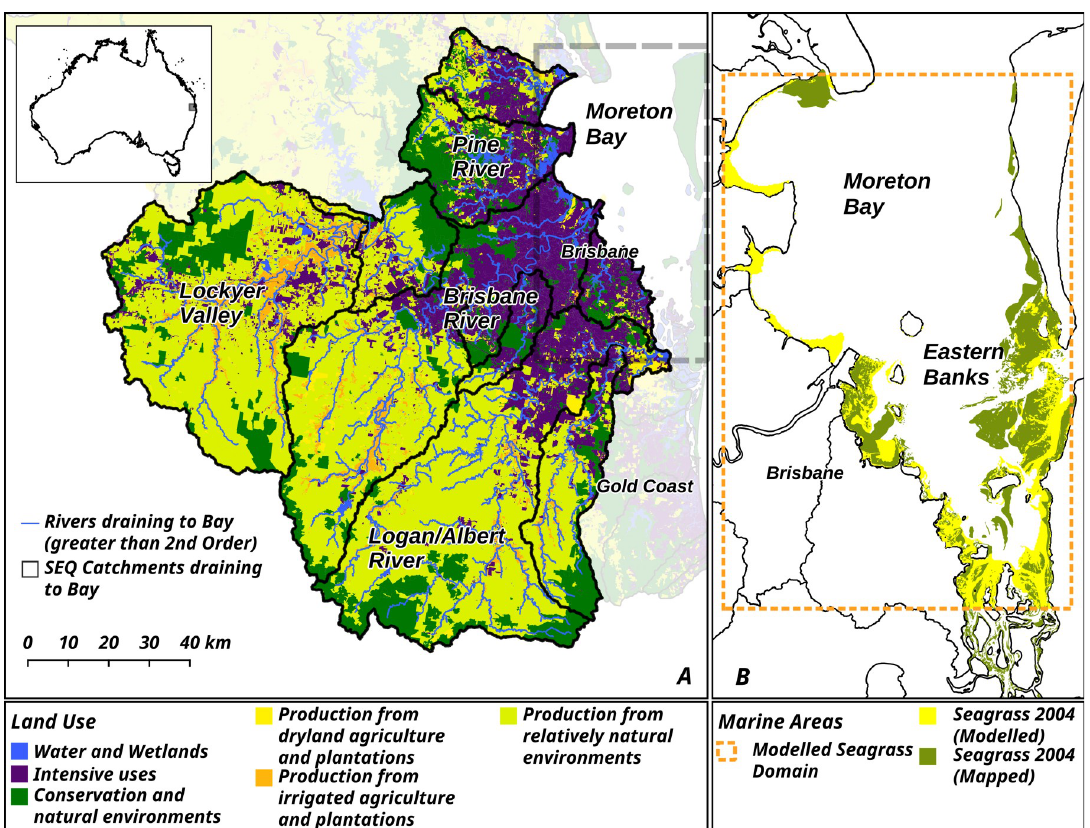
Fig 6. Map of the Moreton Bay area of Queensland, Australia, site of the seagrass case study in Saunders et al. Image reproduced under CC-BY 4.0 license, credit: 10.1371/journal.pbio.2001886.